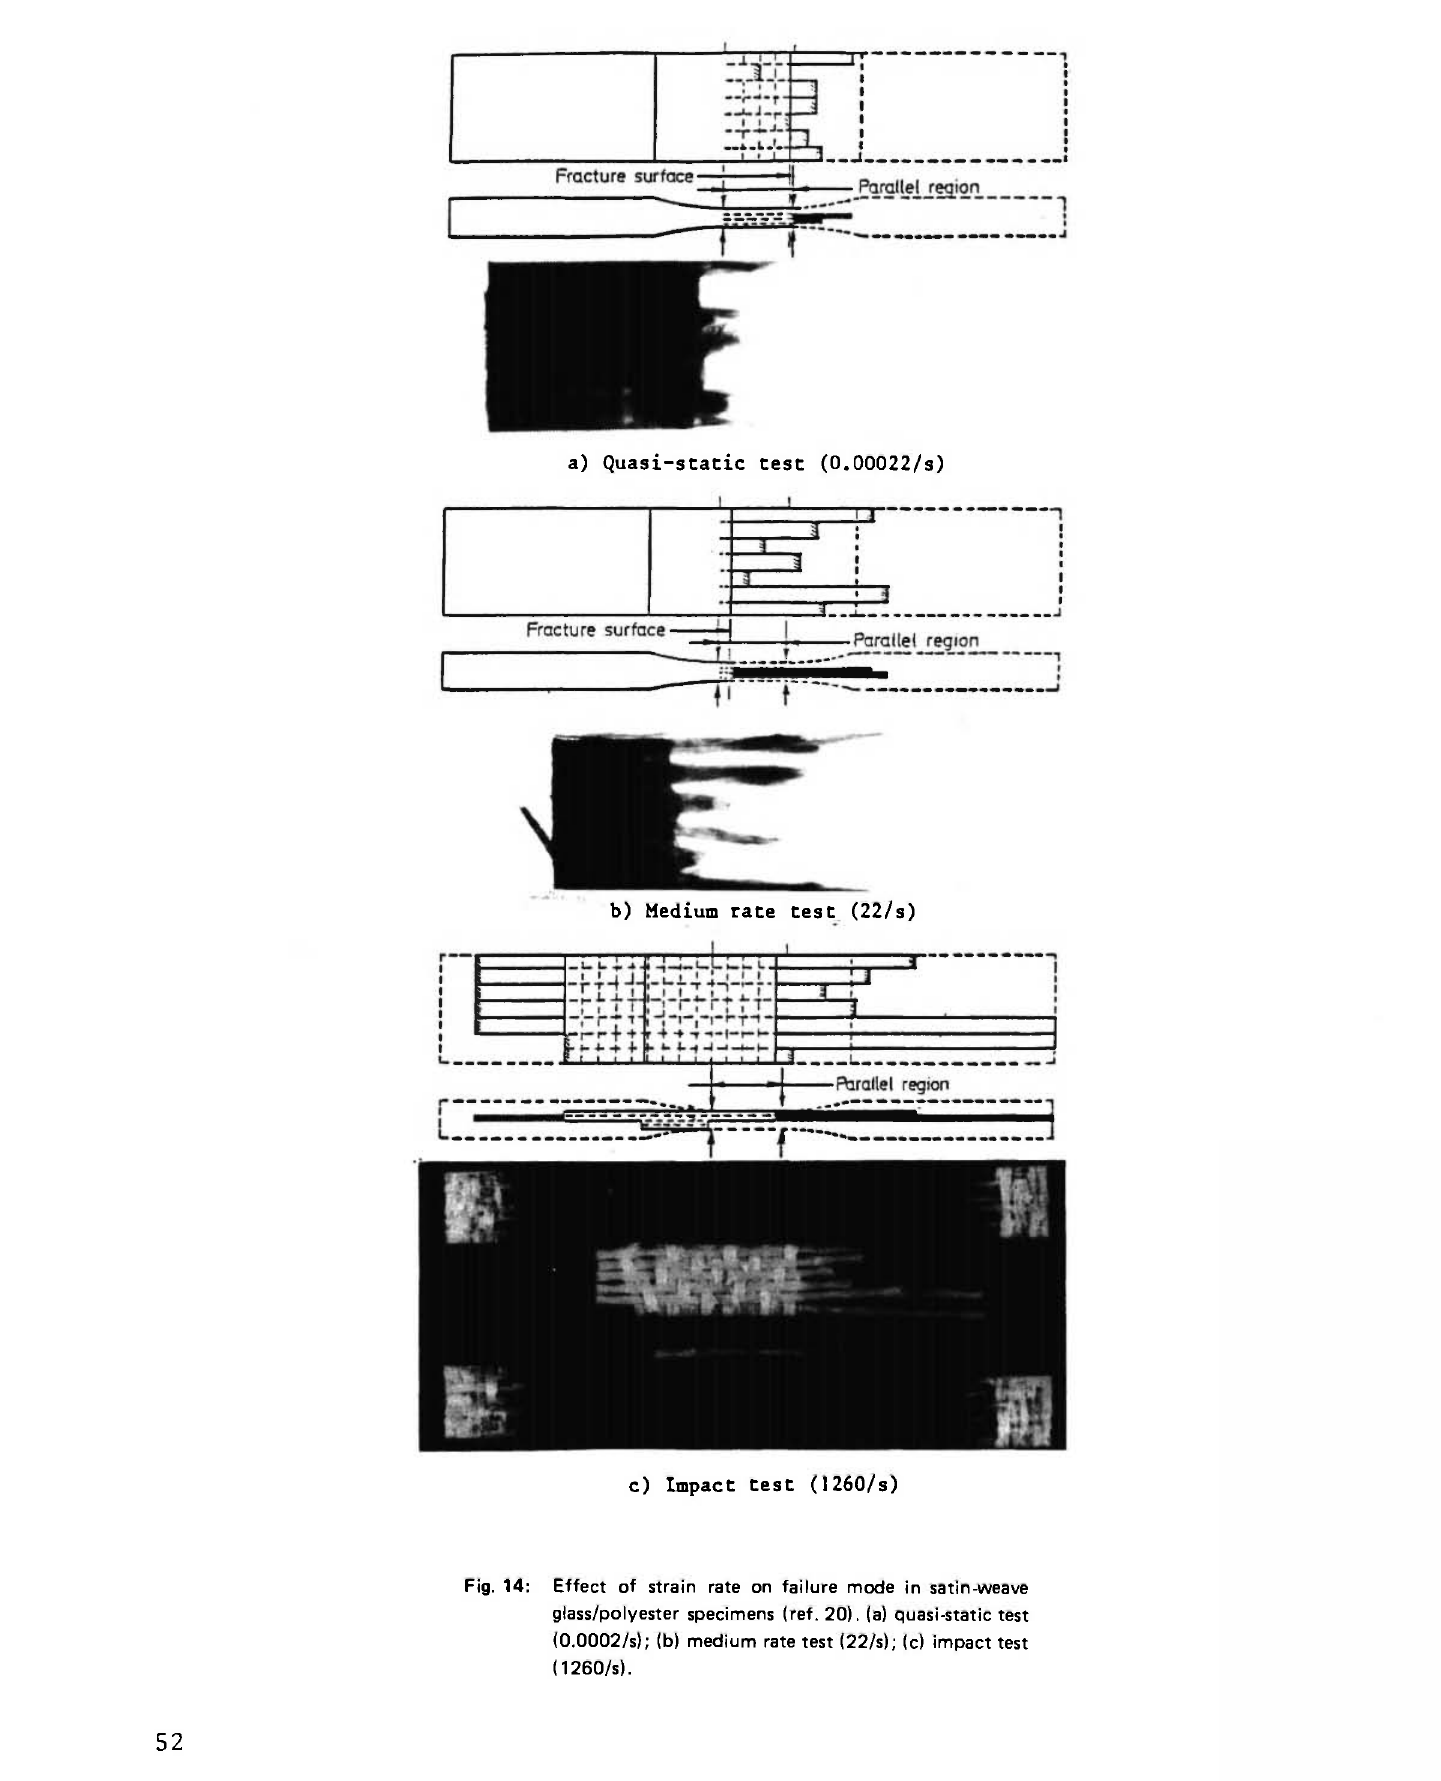
Fig. 14: Effect of strain rate on failure mode in satin-weave glass/polyester specimens (ref. 20). (a) quasi-static test (0.0002/s); (b) medium rate test (22/s); (c) impact test